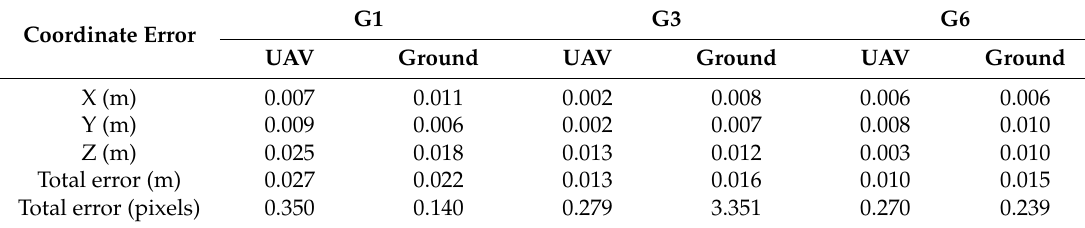
Table 3. Georeferencing error of GCPs for the UAV and ground survey. Error (m) is calculated as the root mean square error between the actual position of the GCPs, derived from RTK measurement, and the estimated position of the GCPs, derived from the SfM-MVS model. Error (pixel) is calculated as the root mean square reprojection error for the GCPs calculated over all photos where the GCPs are visible.